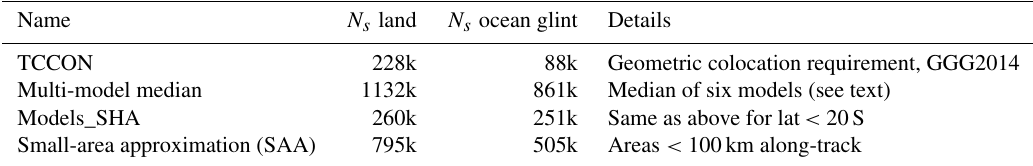
Table 6. X CO truth proxies for retrieval 2